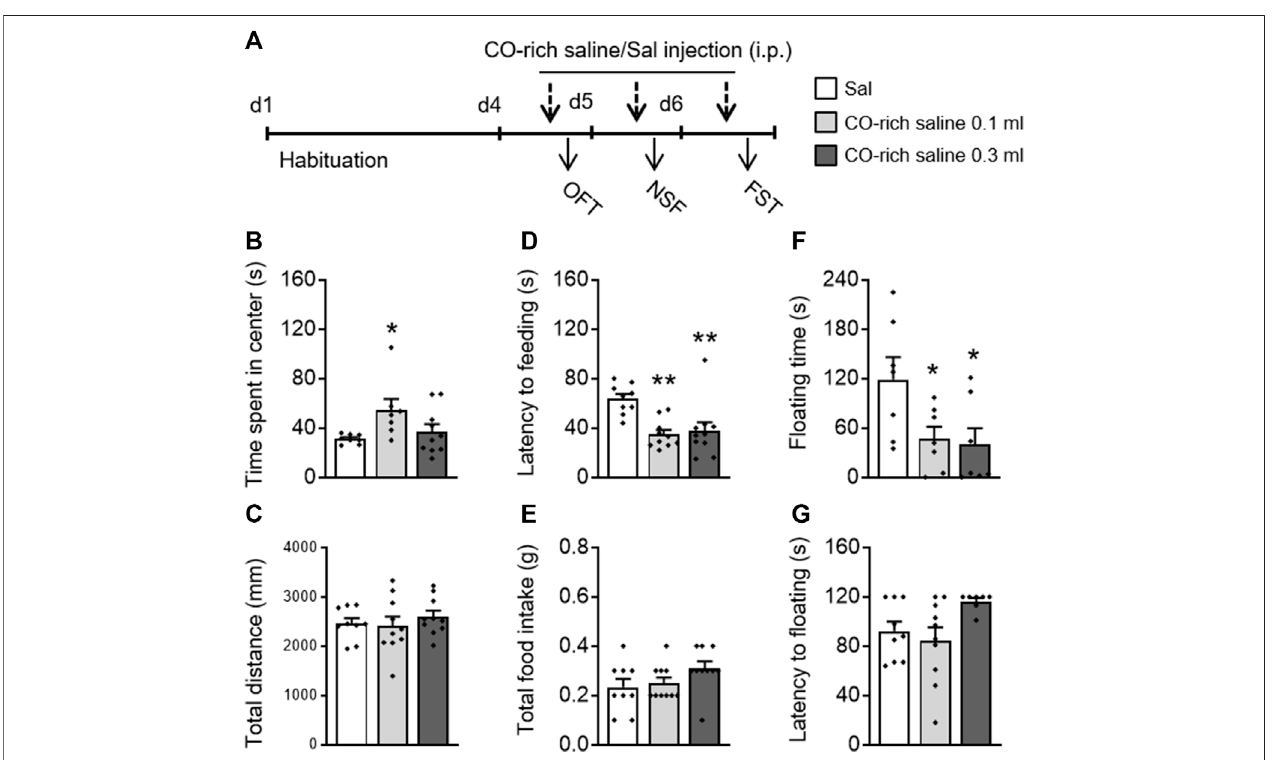
FIGURE 3 | Systemic CO-rich saline pretreatment exerted rapid antidepressant- and anxiolytic-like effects in mice. (A) Saline (0.3 ml, i.p.) or CO-rich saline (0.1, 0.3 ml, i.p.)wasadministereddaily 30 min before each behavioral test. CO-richsaline (0.1 ml) treatment signi fi cantlyincreasedtimespentin thecentral zone (B) without effecting locomotion activity, demonstrated by the total distance traveled (C) in the OFT. CO-rich saline treatment signi fi cantly decreased latency to feeding (D) but not total food intake (E) in the NSFtest. In the FST, fl oating time (F) wasdecreased byCO-richsaline but not latency to fl oating (G) . Thedata are expressed asmean ± SEM and were analyzed with separate one-way ANOVAs. * p < 0.05, ** p < 0.01, ascomparedto thesaline-treated group; Sal, saline. OFT, open fi eld test; NSF, novelty- suppressed feeding; FST, forced swimming test ( n (cid:2) 8 – 9 per group).